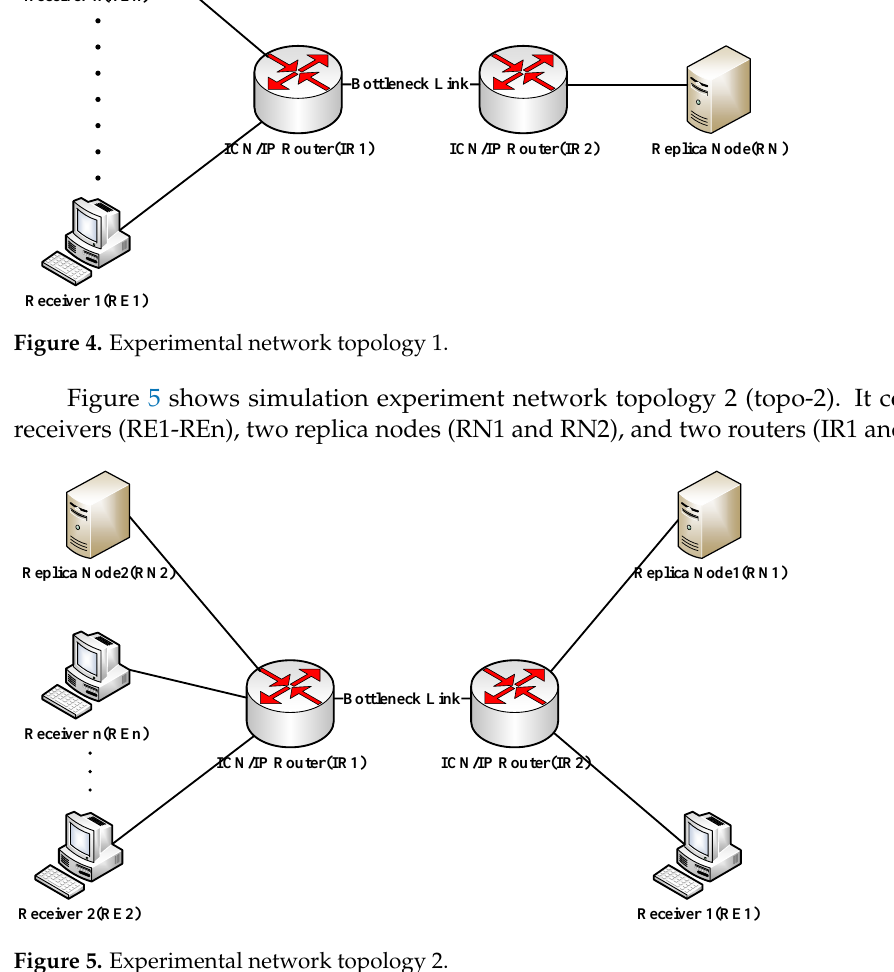
Figure 5. Experimental network topology